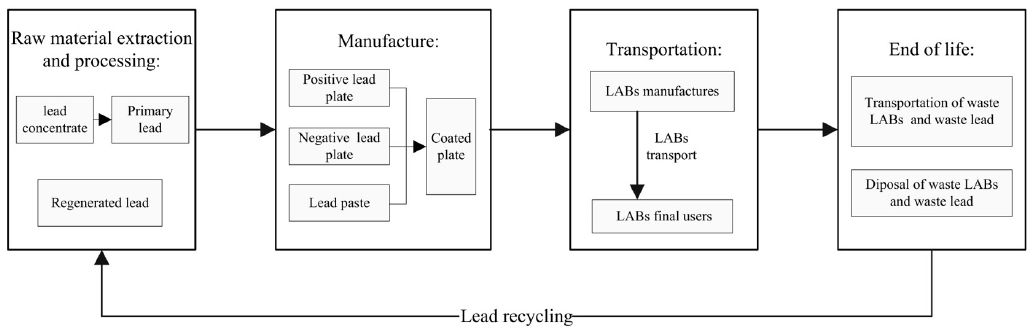
Figure 3. System boundary of the life cycle assessment for lead-acid batteries based on lead material flow.